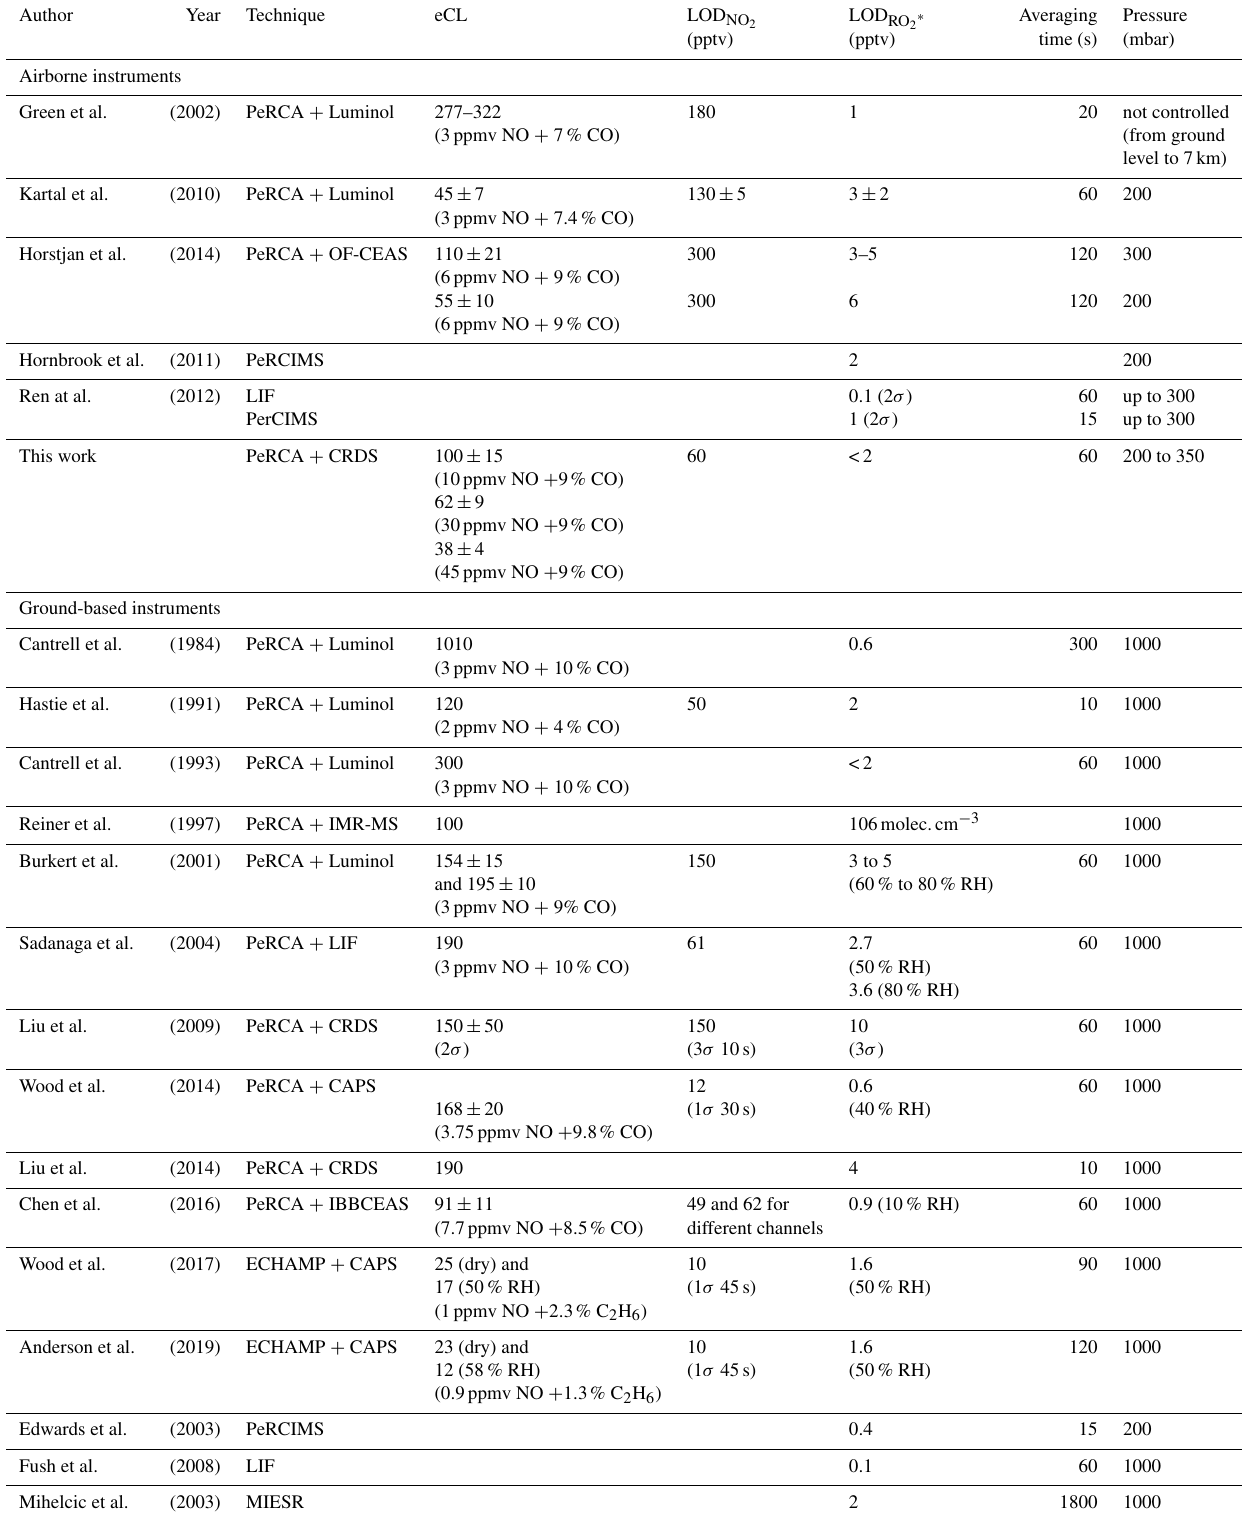
Table 4. State-of-the-art instruments for the airborne measurement of peroxy radicals. Ground-based instruments are also included for comparison.